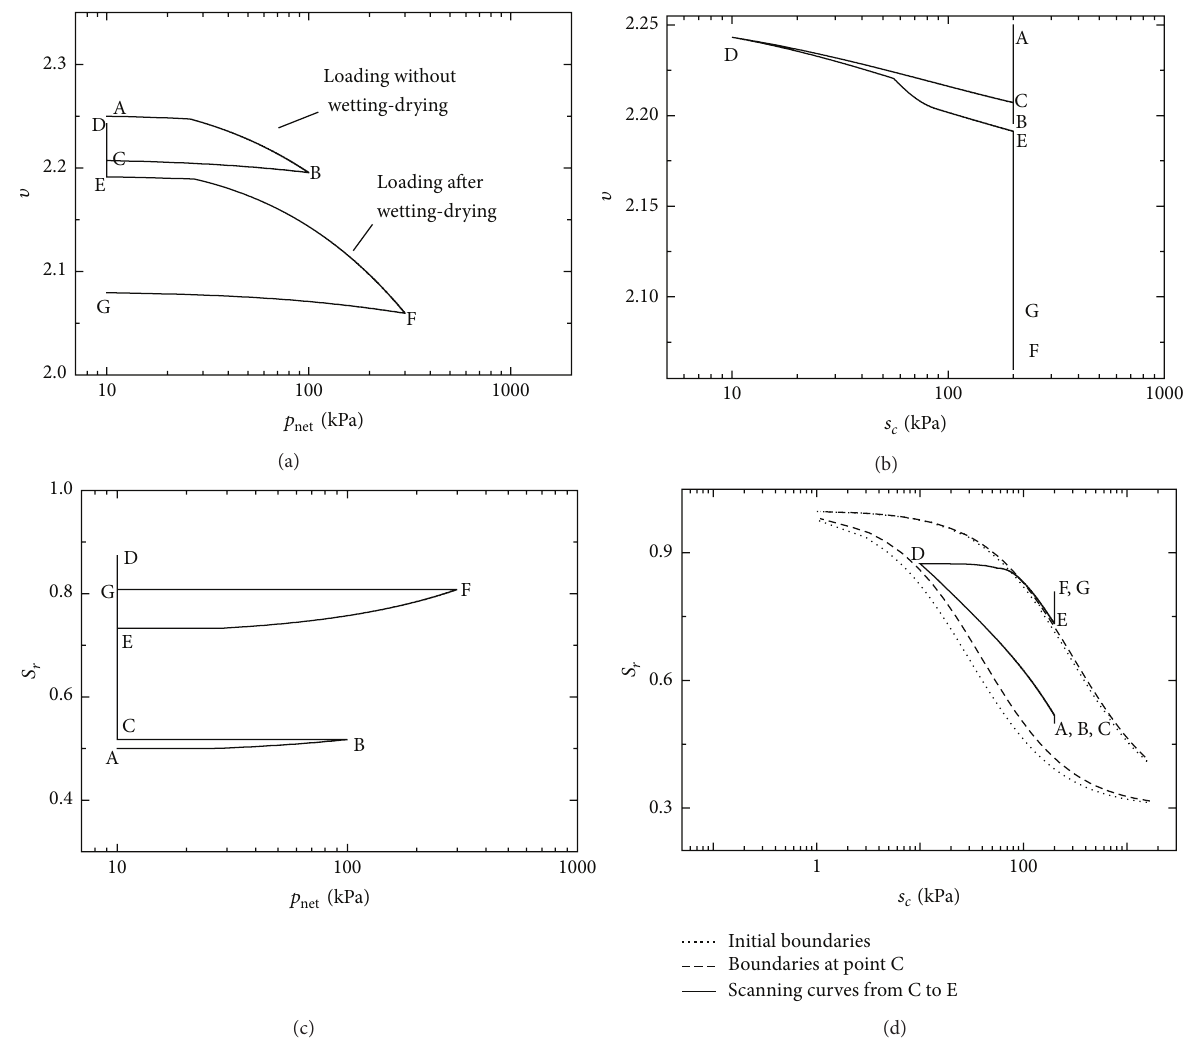
= 290 kPa, 𝑏 0 = 30 kPa, 𝑑 0 = 𝑑 0 = 1.0 , DR WT DR WT